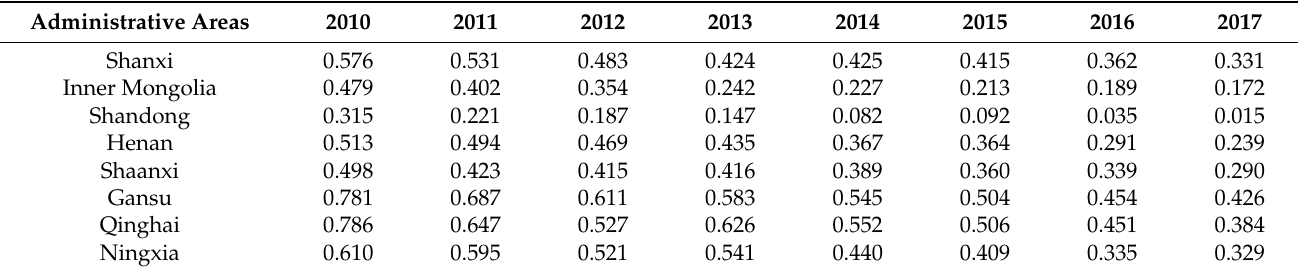
Table 5. Values of uncoordinated coupling